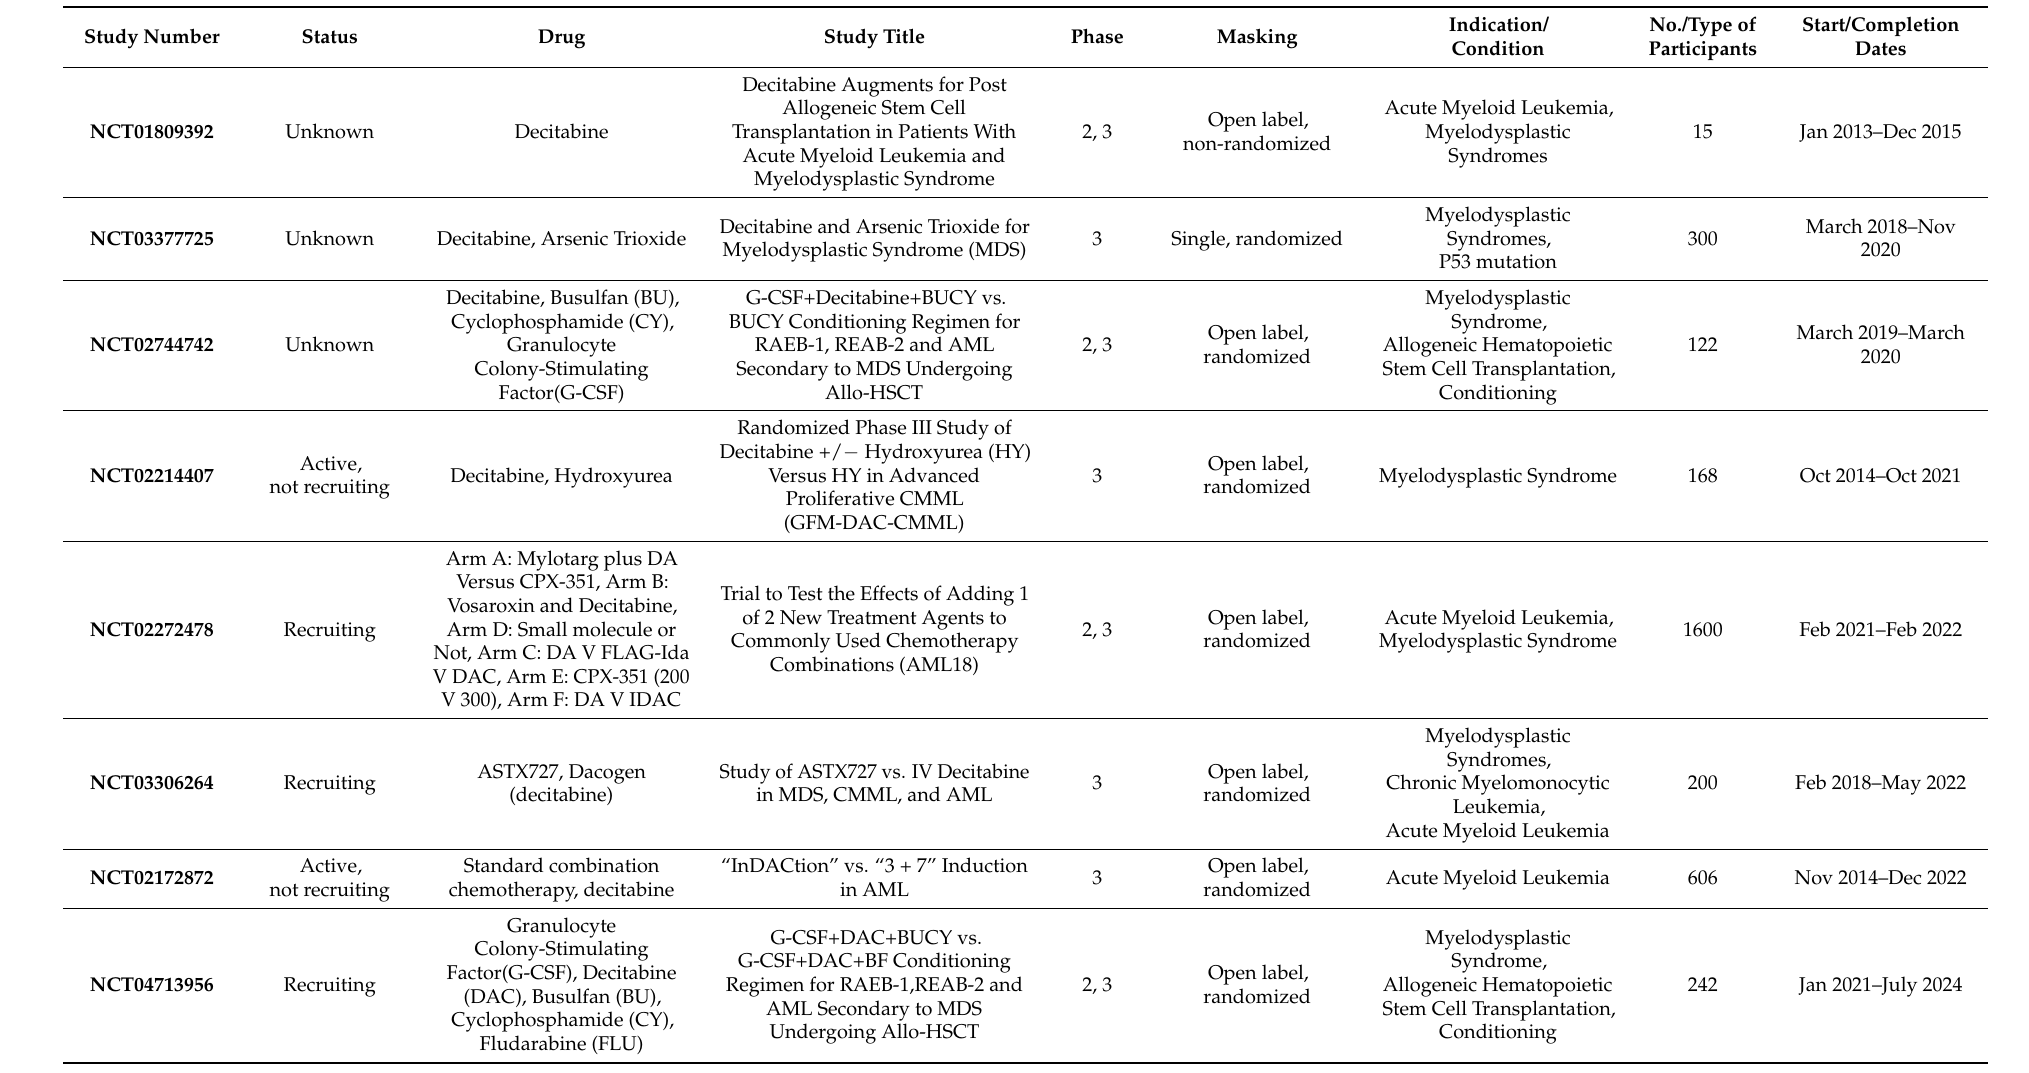
Table 1. This table shows phase III clinical trials for decitabine, azacytidine and bortezomib in hematological